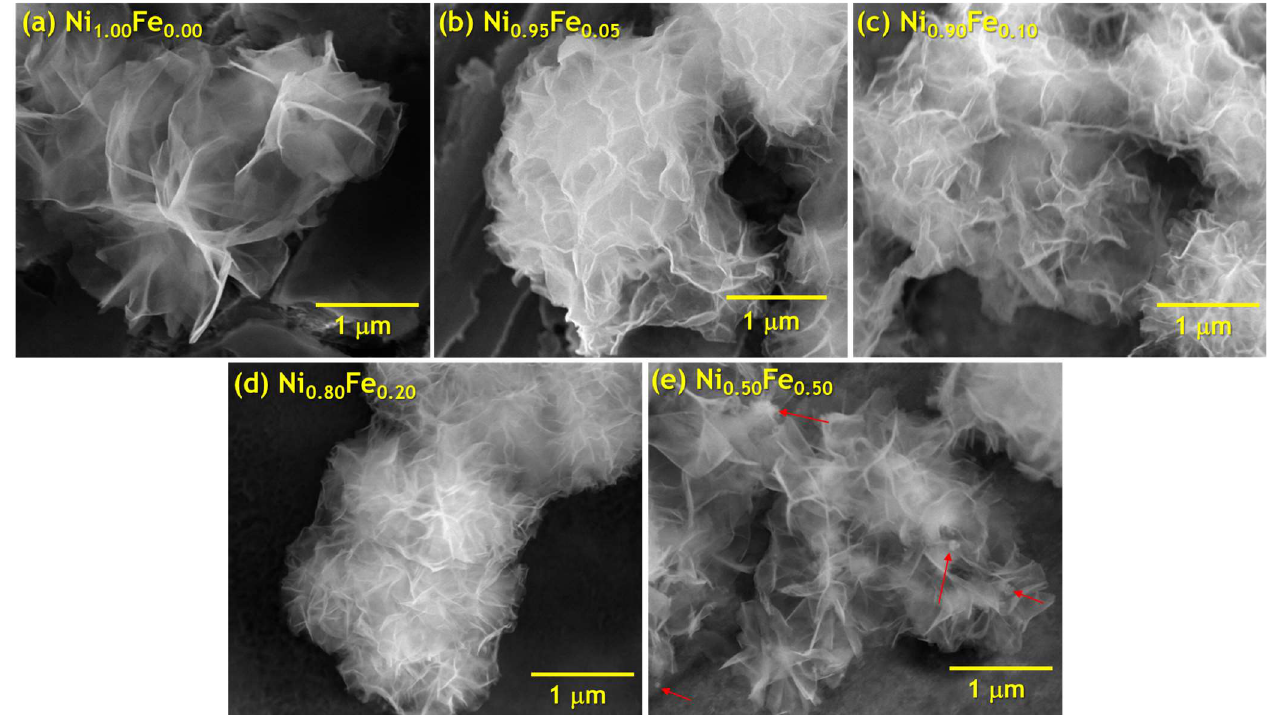
Figure 1. Scanning electron micrographs of the microwave synthesized nanosheets; ( a ) Ni 1.00 Fe 0.00 , ( b ) Ni 0.95 Fe 0.05 , ( c ) Ni 0.90 Fe 0.10 , ( d ) Ni 0.80 Fe 0.20 , and ( e ) Ni 0.50 Fe 0.50 ; red arrows point to changes in morphology within the Ni 0.50 Fe 0.50 material.